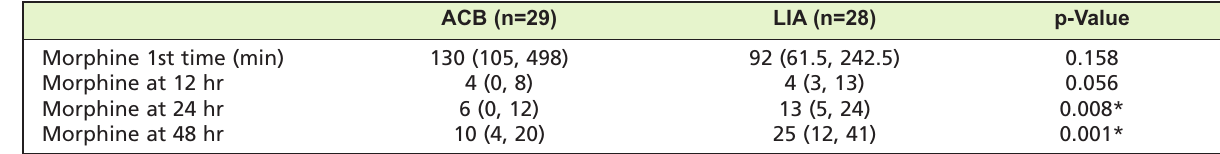
Total morphine consumption (mg) Table II: